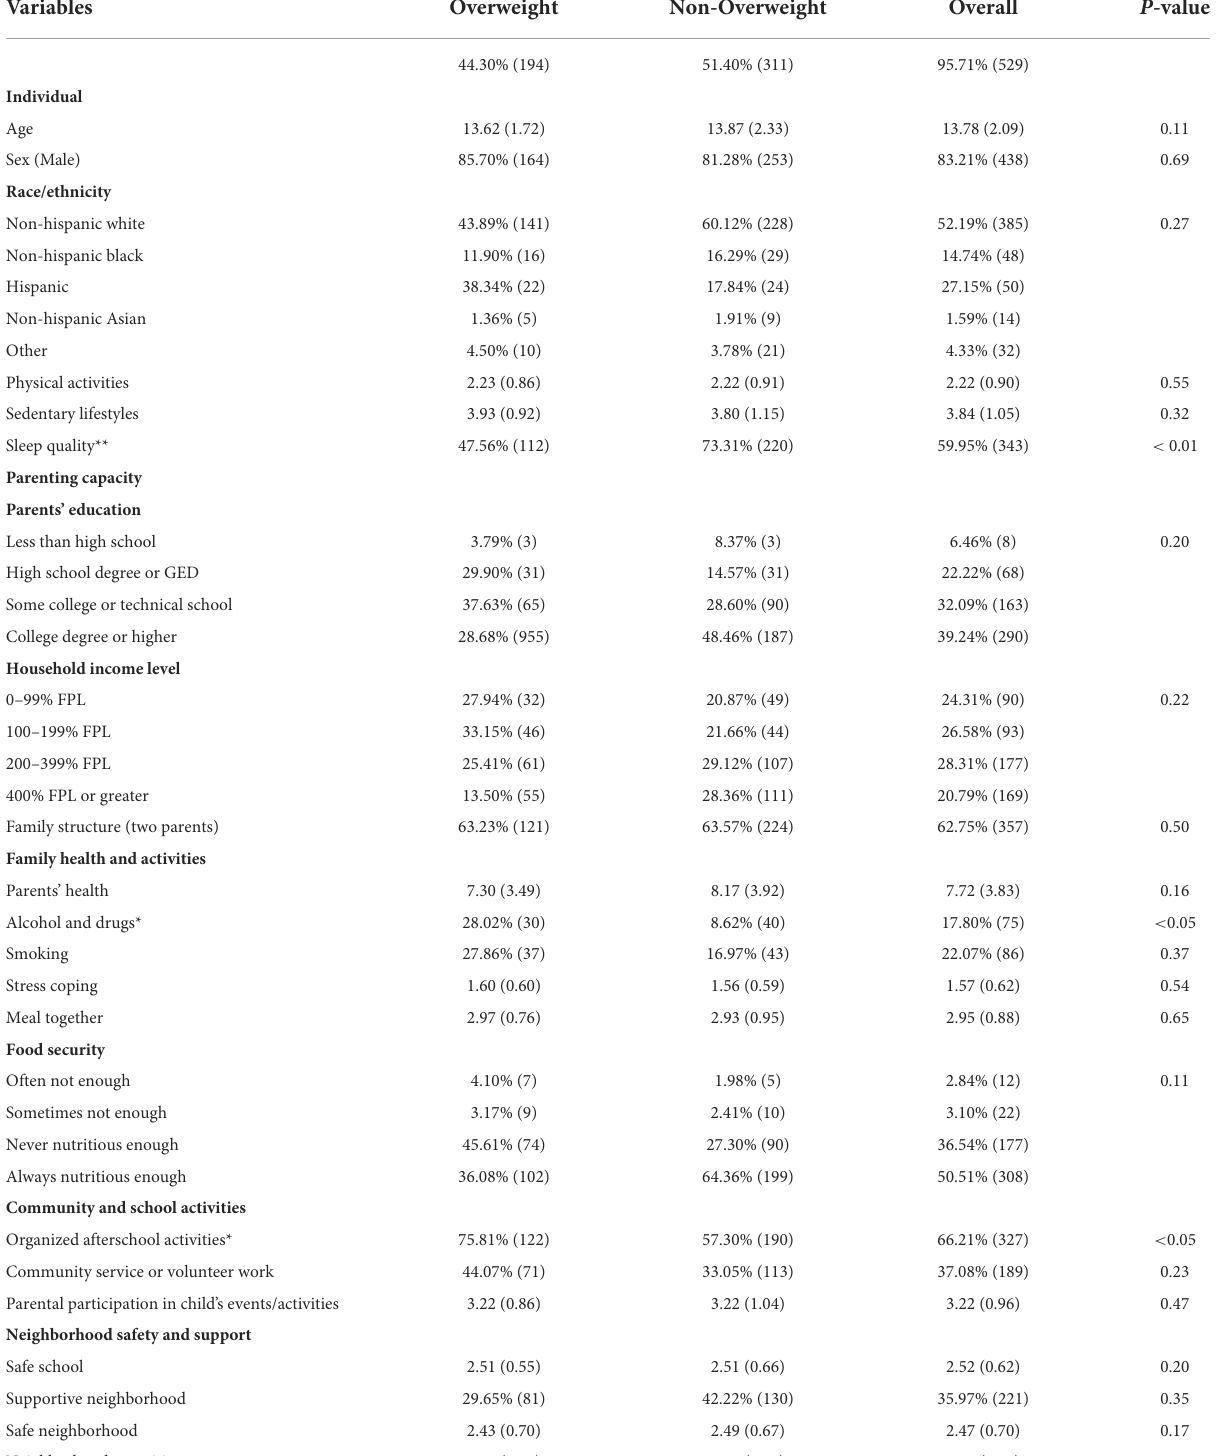
TABLE 1 Characteristics of study participants with overweight